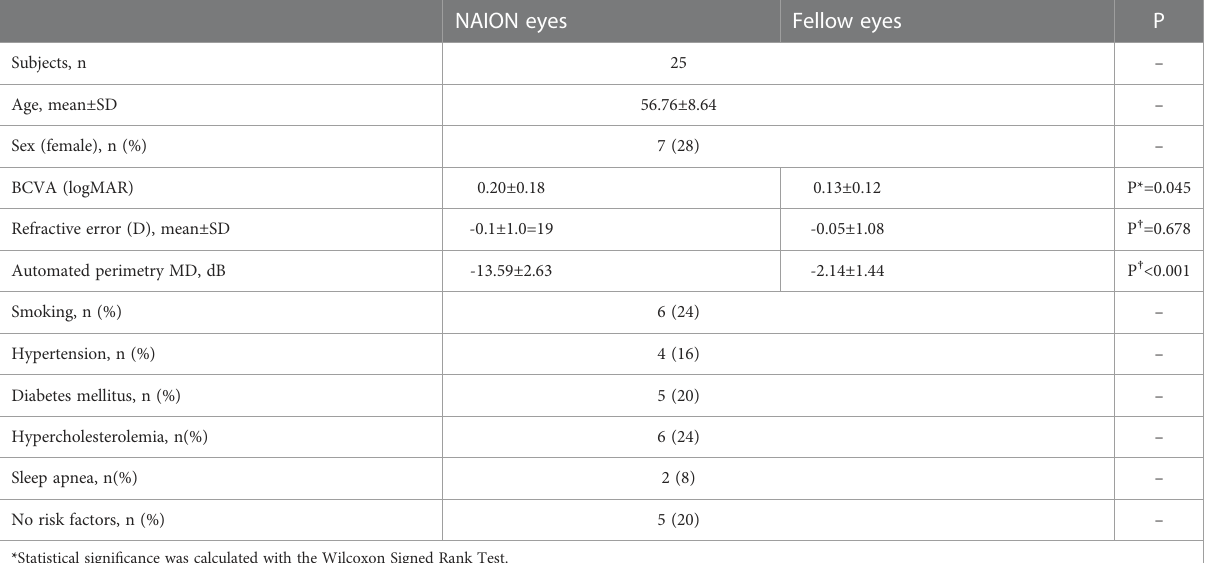
TABLE 1 Demographic characteristics of